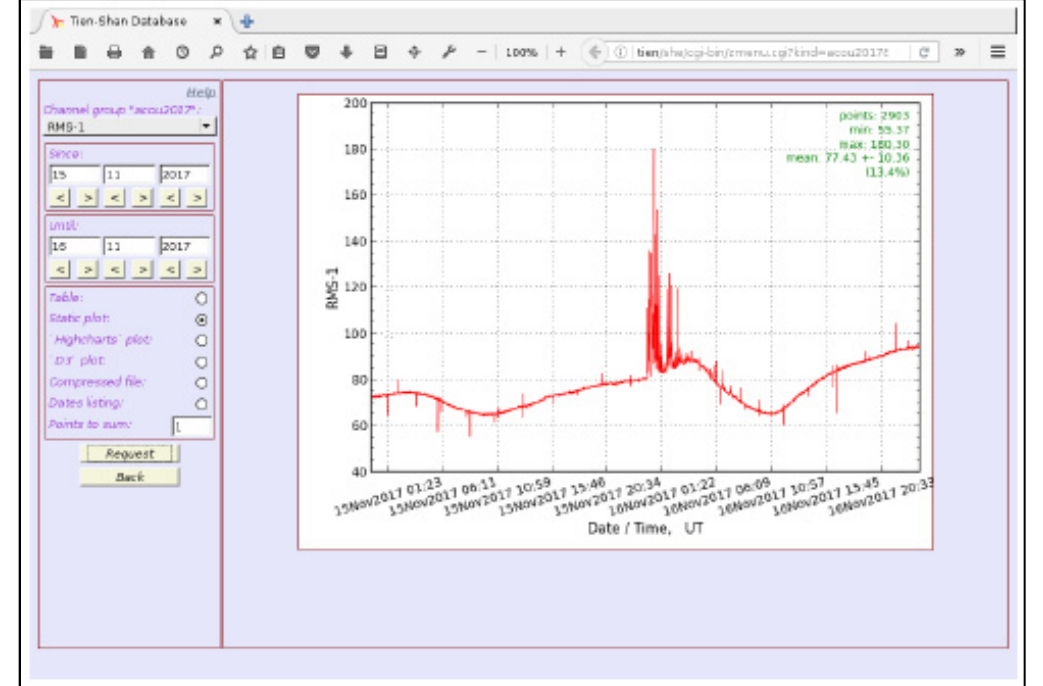
Figure 6. Results of long-term measurements with an acoustic detector presented on the web page of the Tien Shan station: root-mean-squared amplitude of the acoustic signal over two days.